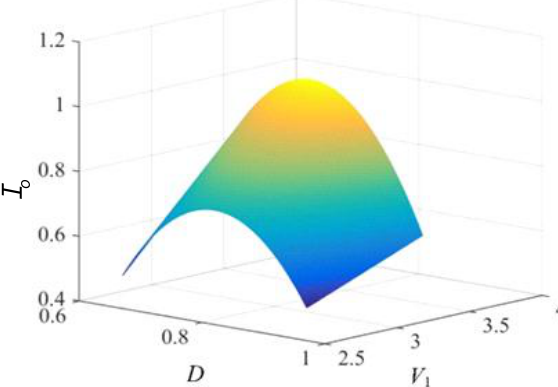
Figure 12. The relationship between the average balancing current, the duty ratio, and the source cell voltage.